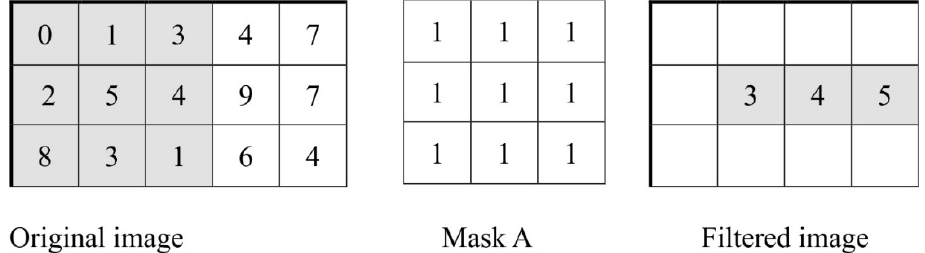
Figure 2. Typical example showing the filtered images generated after the applying of filter with the new values.